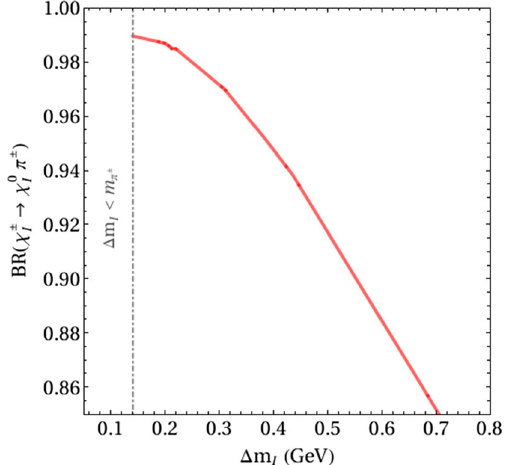
→ ˜ χ 0 π ± ) as a function of the inert mass splitting Fig. 3 BR ( ˜ χ ± I I Δ m I . Below the charged pion mass threshold the only allowed decay → l ± ν ˜ χ 0 channel is a 3-body decay ˜ χ ± I